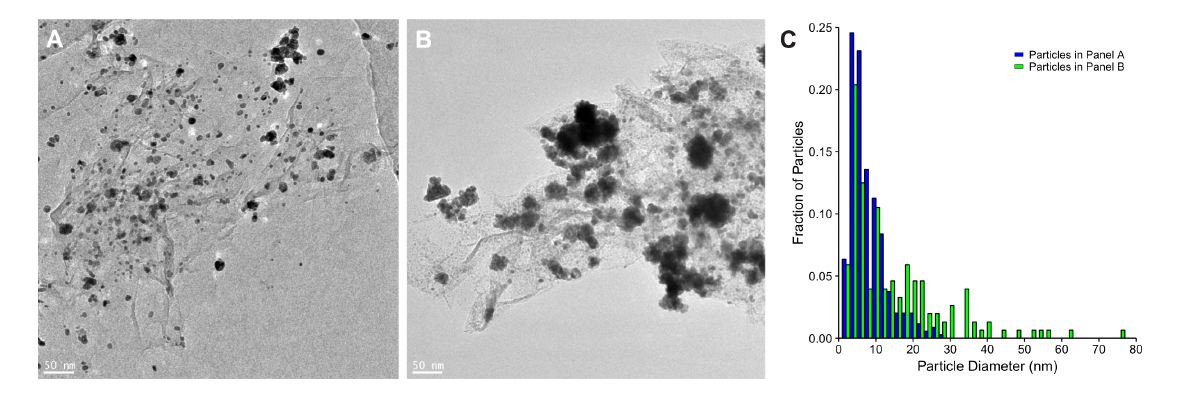
Figure 1: Representative TEM micrographs of: A) final rGO–Pt dispersion, B) sediment rGO–Pt. The scale bars represent 50 nm. C) Histogram of Pt particles observed in panel A (blue) and panel B (green) (bin width = 2).